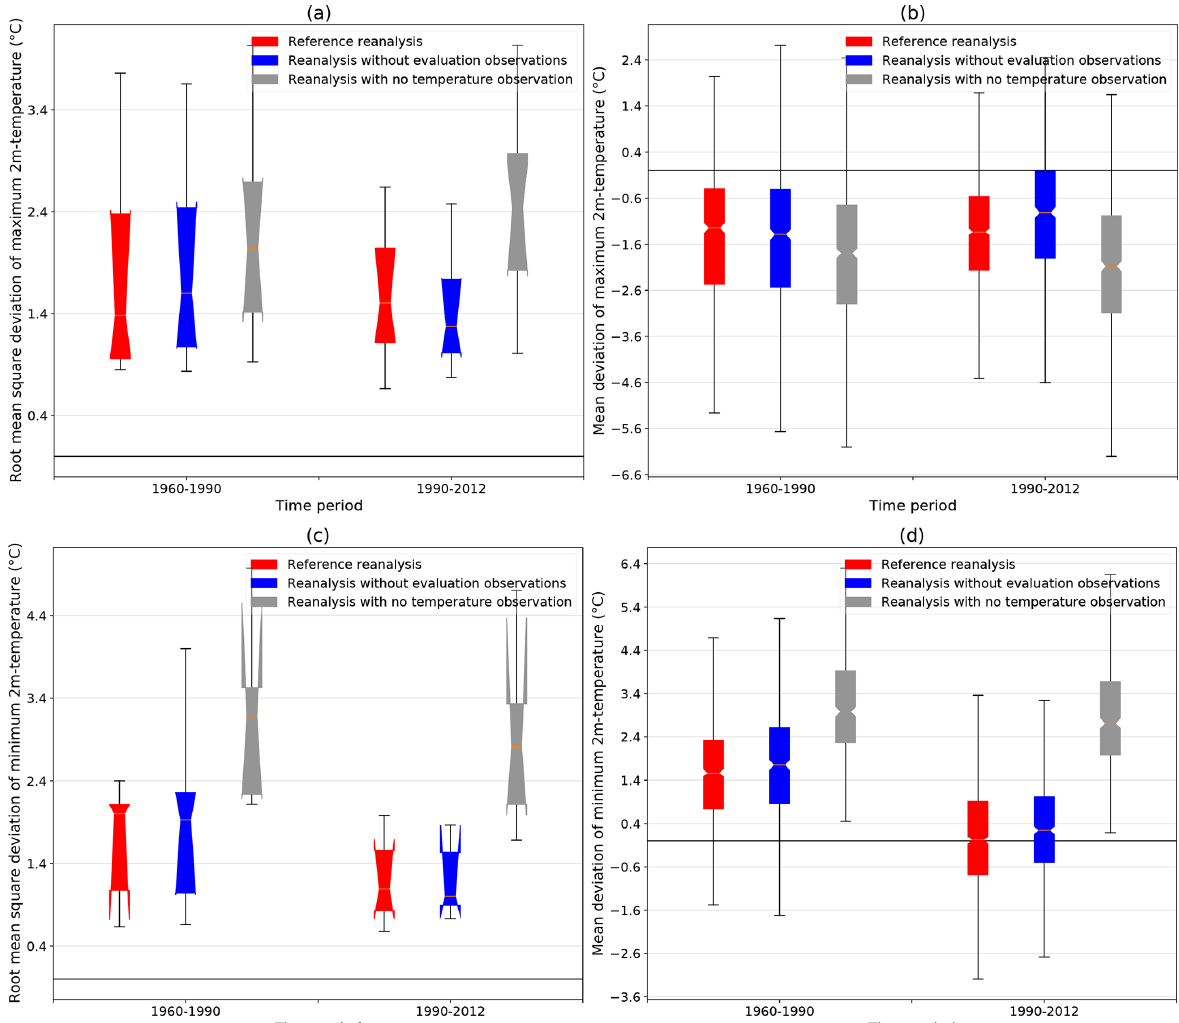
Figure B1. Same as Fig. 10 but for winter (DJF) 2m temperatures